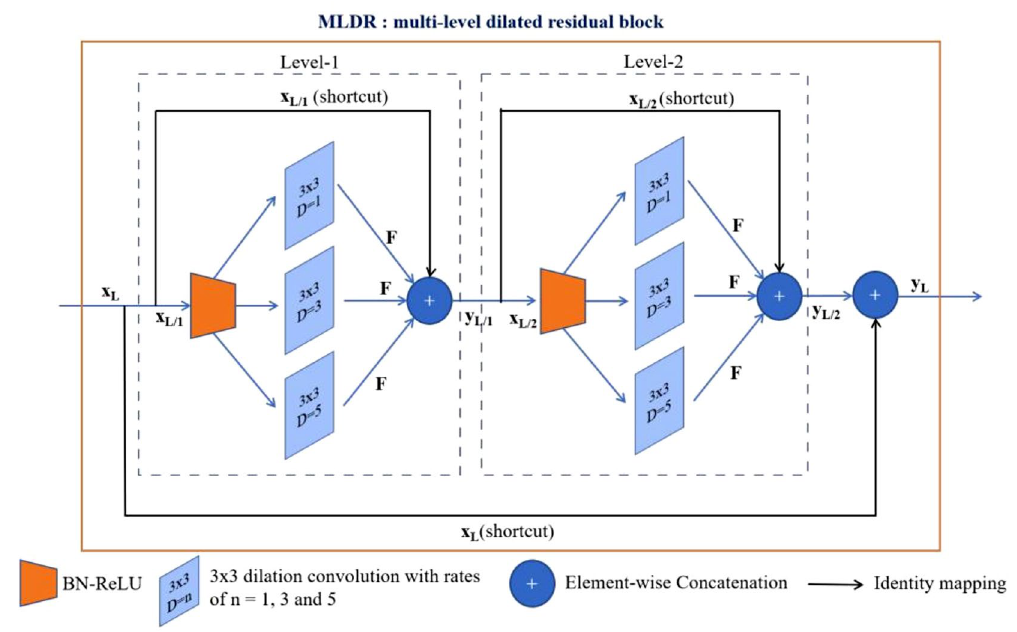
Figure 2. A schematic representation of the MLDR block. In this study, we suggest replacing the convolutional block in the classical U-Net 6 with the MLDR block. Each MLDR block consists of two levels, each having a sequence of BN-ReLU followed by three 3 × 3 parallel dilated convolutions at dilation rates of 1, 3, and 5 with the residual connection, to extract features at different